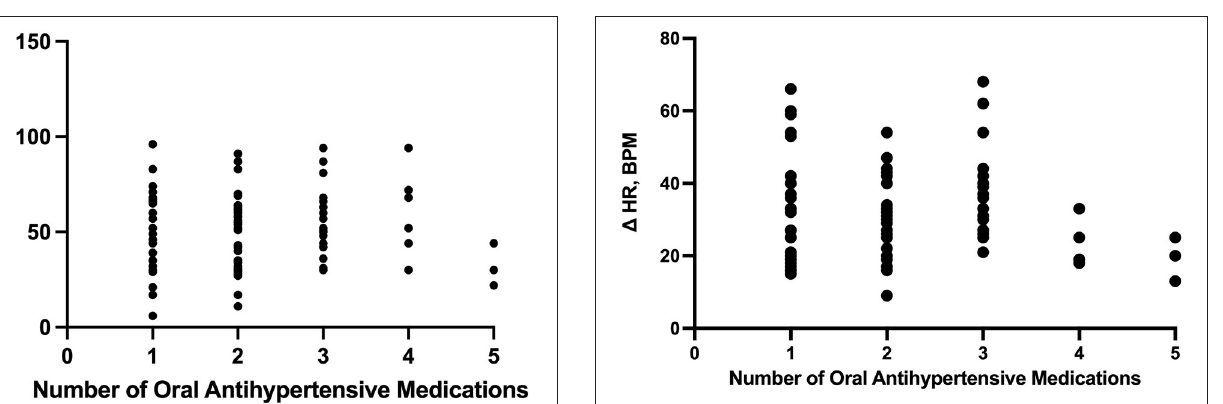
FIGURE 3 | Correlation between the number of enteral (PO) agents and heart rate delta. HR, heart rate; PO, per os (enteral).